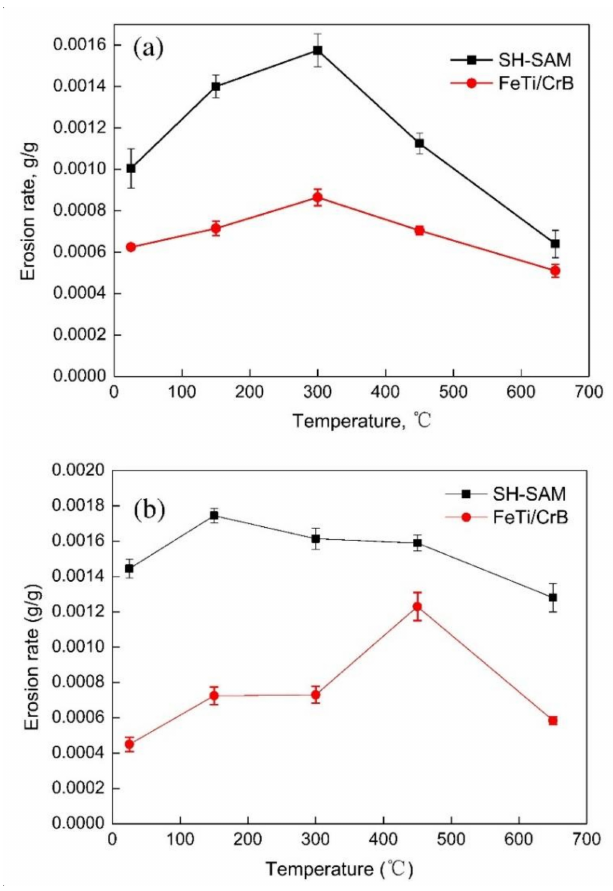
Figure 9. Erosion rates of FeTi/CrB and SH-SAM coatings at ( a ) 30 ◦ and ( b ) 90 ◦ impact angles. Reprinted with permission from ref. [22]. Copyright 2015